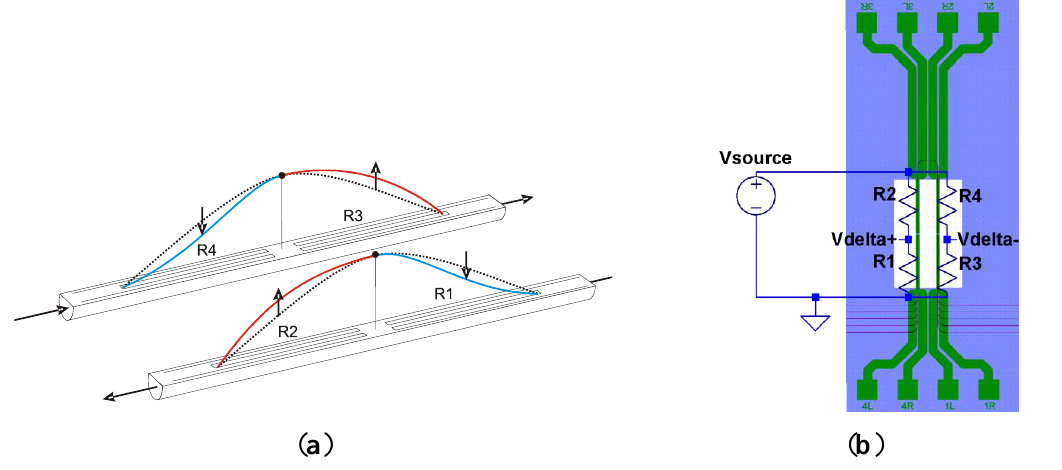
Figure 2. ( a ) Thermal flow sensor with ( b ) Wheatstone bridge